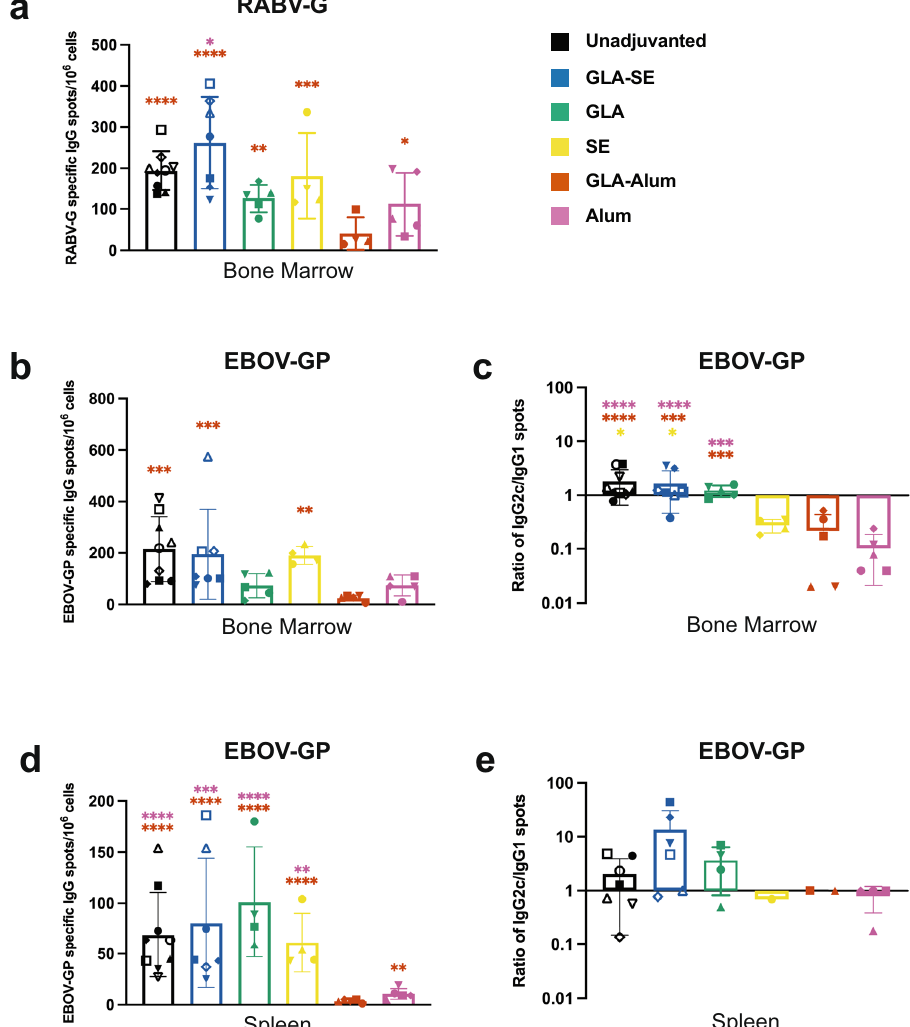
Fig. 7 Long-term antibody responses to FILORAB1 are maintained by long-lived antibody-secreting cells (ASCs) in the bone marrow and spleen. a The average number (line) of RABV-G and b EBOV-GP speci fi c ASCs present in individual mouse bone marrow (symbols) at 1 year per adjuvant group. c The ratio of IgG2c/IgG1 ASCs speci fi c to EBOV-GP in the bone marrow. d The average number of EBOV-GP speci fi c ASCs present in individual mouse spleens at 1 year per adjuvant group. e The ratio of IgG2c/IgG1 ASCs speci fi c to EBOV-GP in the spleens. Statistics are by one-way ANOVA with post hoc Tukey ’ s test of the log-transformed total number of cells or ratios. p > 0.1234 (ns), p < 0.0332 (*), p < 0.0021 (**), p < 0.0002 (***), p < 0.0001